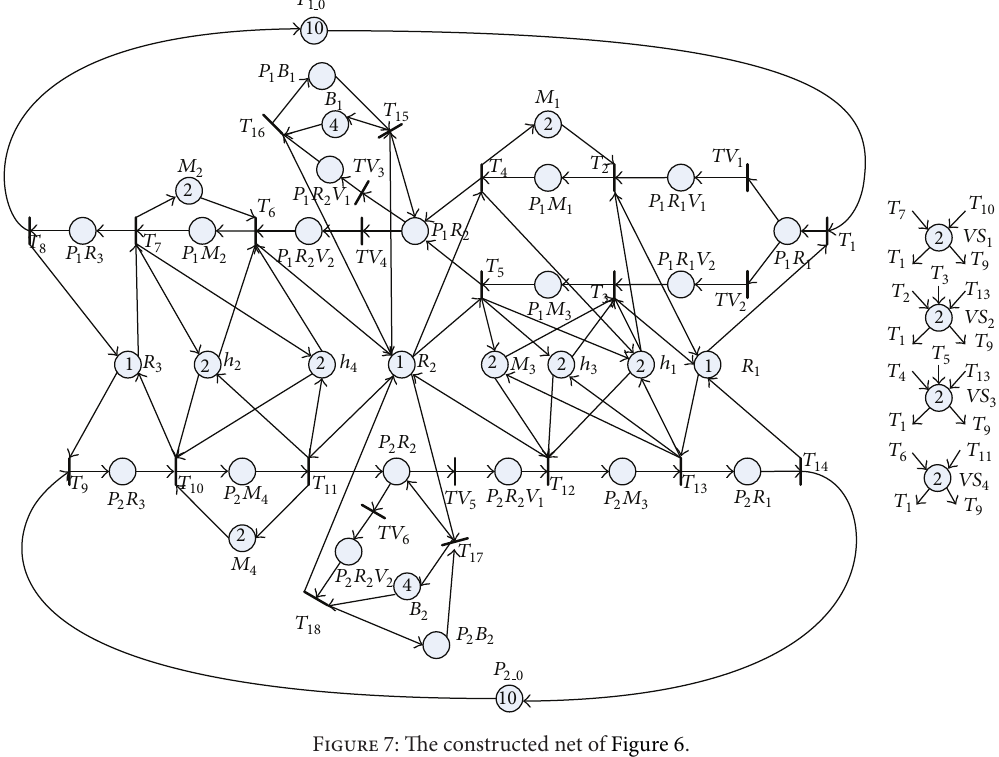
Figure 7: The constructed net of Figure 6.